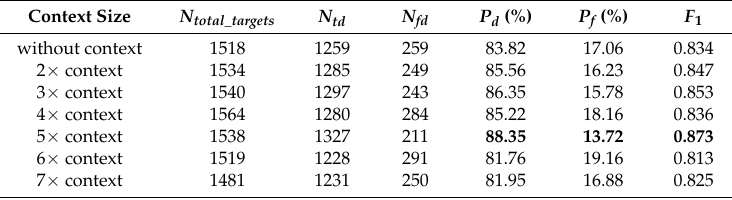
Table 2. Detection performance comparisons between different sized contextual features.